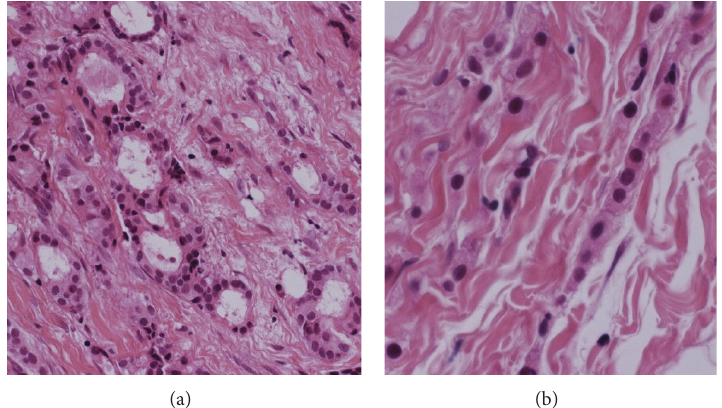
Figure 4: (a) Several malignant ductal structures in a desmoplastic stroma (H&E stain, magnification × 20). (b) Breast biopsy shows typical lobular carcinoma pattern with Indian filing (H&E stain, magnification × 40).